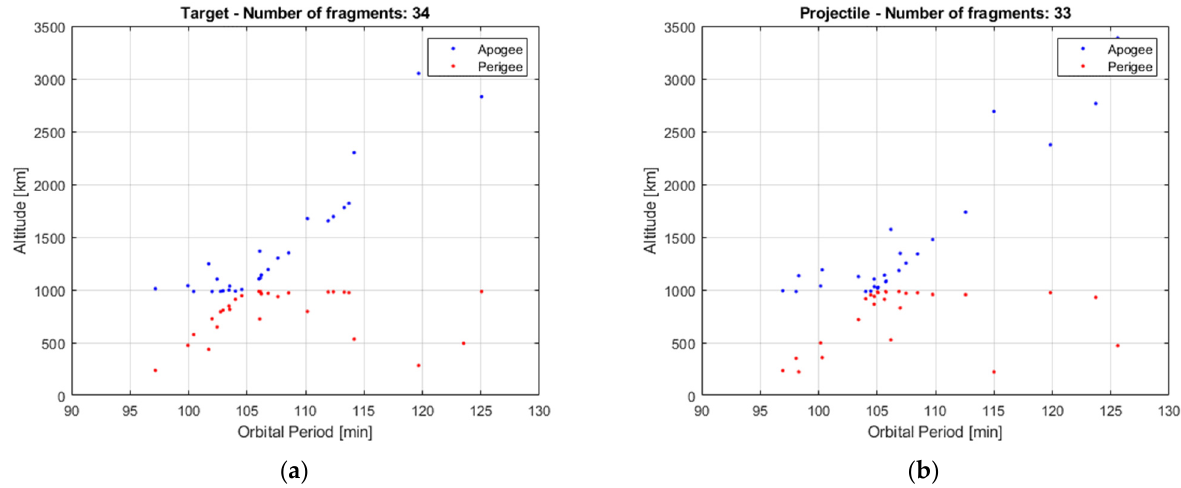
Figure 17. Gabbard diagrams for the target ( a ) and the projectile ( b ), obtained with fragmented masses estimated by